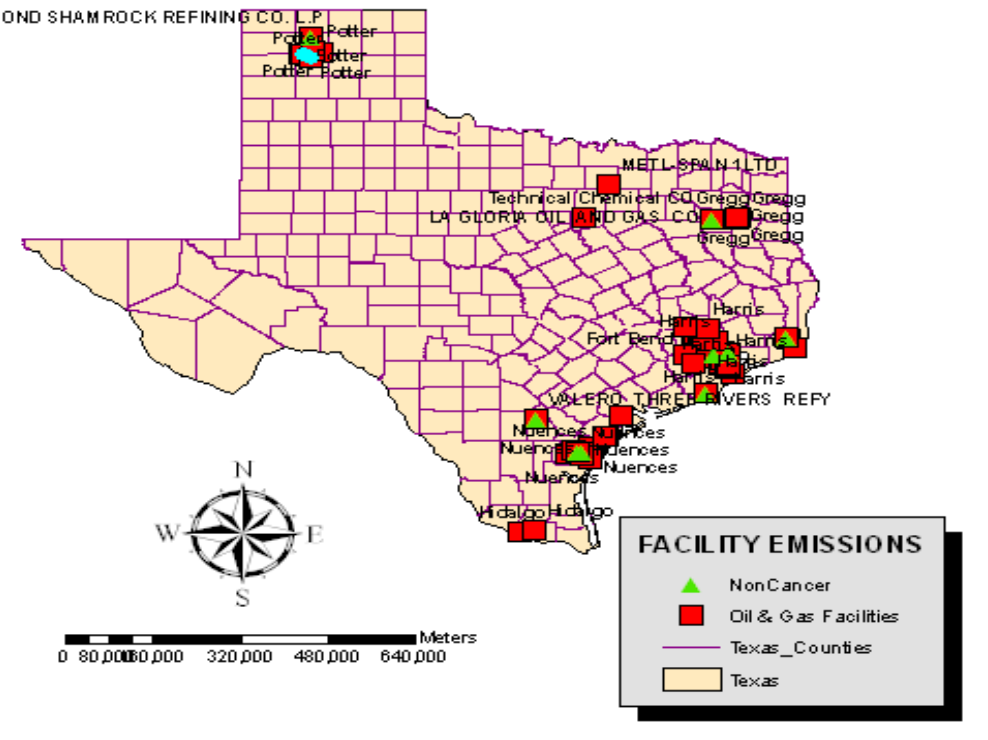
Figure 10. Spatial Concentration of Facilities Emitting Non-Cancer Causing Substances of Toluene.